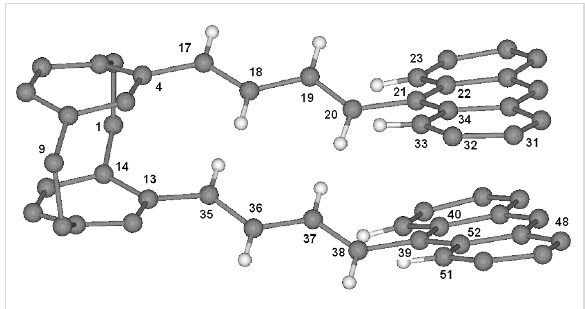
Figure 4: Molecular structure of 2 in the crystal. Radii are arbitrary; only selected H atoms are shown. The double bonds are clearly all- trans and their average planes form twist angles with the two anthracene nuclei of 47° and 44°,respectively; the two ethylenic systems are also not parallel to each other but subtend twist angles of 42–43° (see Table 1).